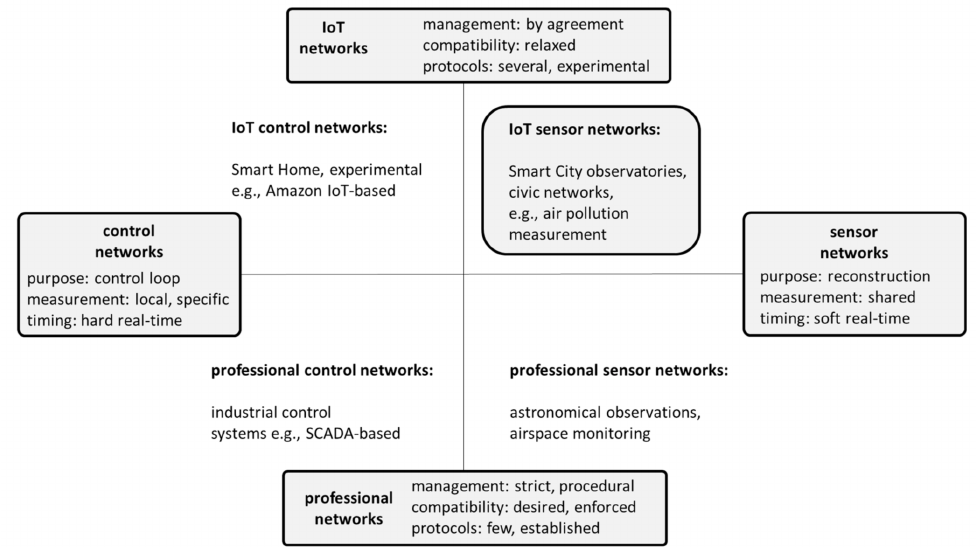
Figure 1. The specificity of IoT sensor